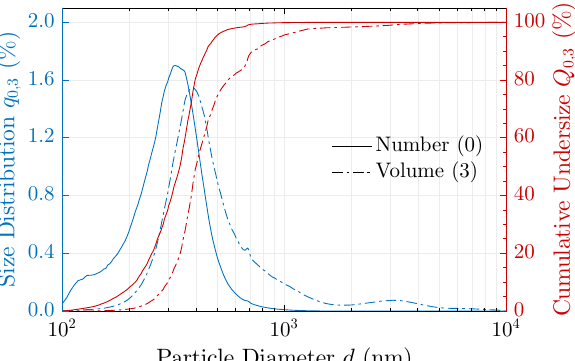
Figure 15. Particle size distribution (blue) and cumulative undersize (red) according to number (solid lines) and volume density (dash-dotted) for a TiO 2